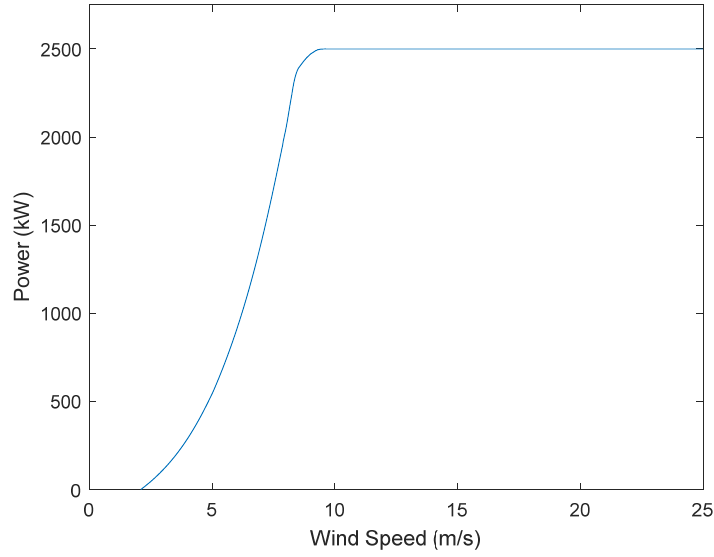
Figure 5. Case study wind turbine power vs wind speed curve.